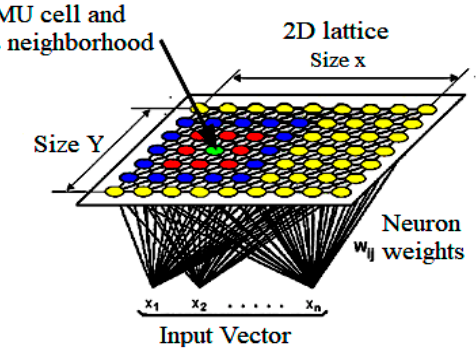
Figure 7. Basic KNN structure [58], BMU= Best matching unit.